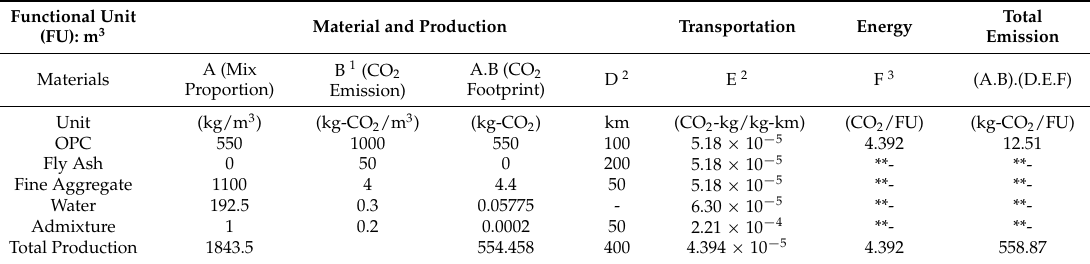
Table 7. Eco-points’ assessment for OPC + 0% fly ash compacting mortar (control).